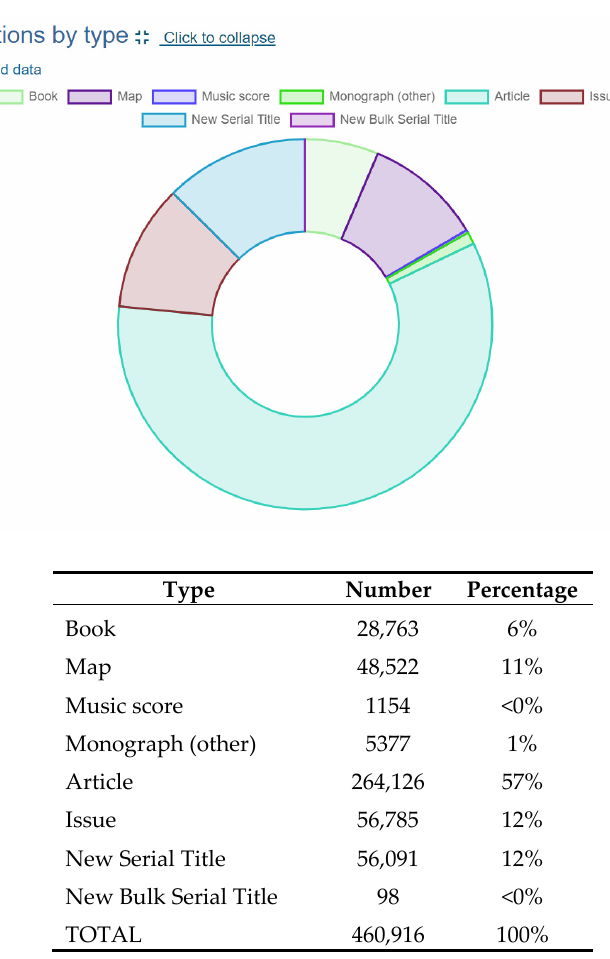
Figure 4. Expanded view of ‘publications by type’ and table of corresponding figures (as at March 2020).